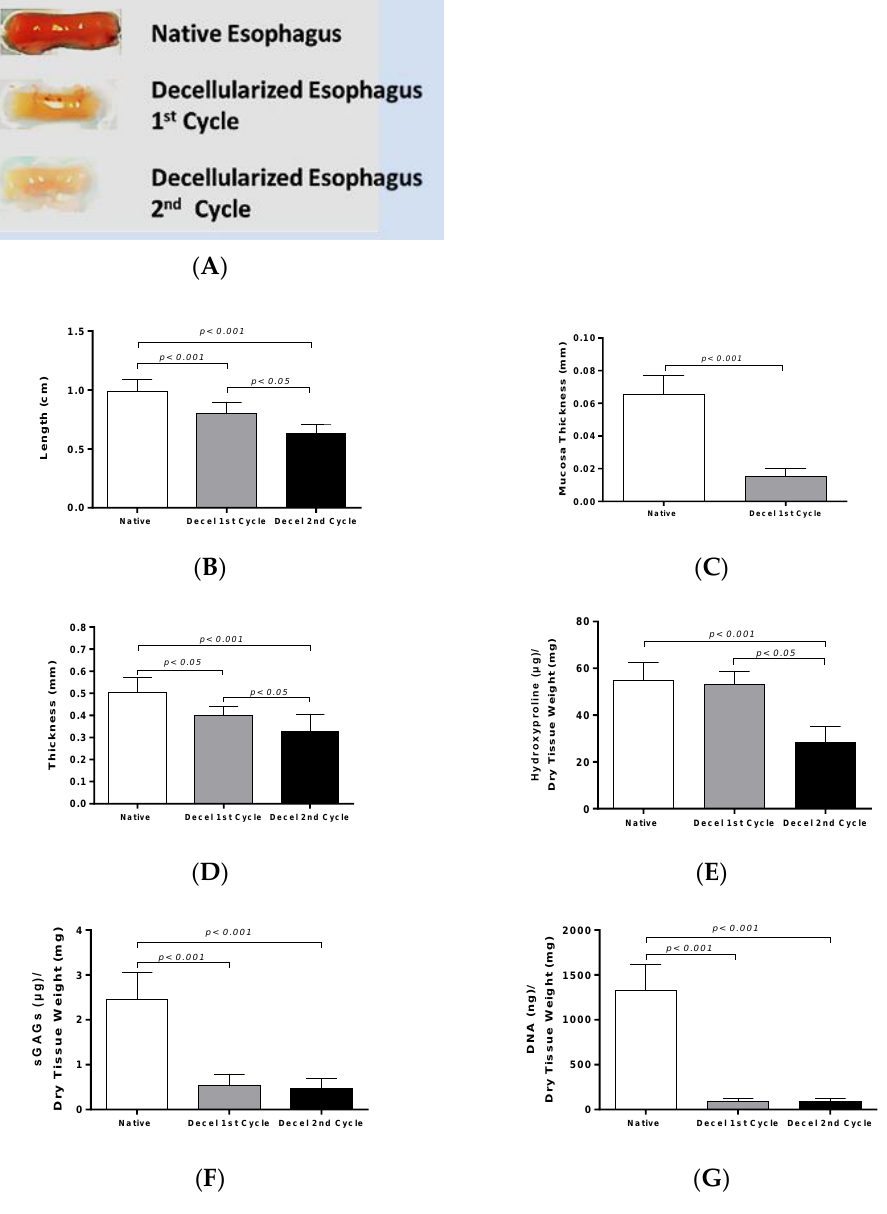
Figure 2. Morphometric analysis and biochemical quantification in rES. Macroscopic overview of native and decellularized rES after the first and second cycles ( A ). Measurement of length ( B ), mucosa thickness ( C ) and total thickness ( D ) in rES. Statistically significant differences were observed in the above parameters between native and decellularized rES either by the first ( p < 0.005) or second cycle ( p < 0.001); Biochemical quantification involved hydroxyproline measurement ( E ); sulfated glycosaminoglycans (sGAGs) ( F ) and DNA ( G ) content determination. Statistically significant differences were observed in collagen, sGAG and DNA content between native and decellularized rES either by the first ( p < 0.05) or second cycle ( p < 0.05).